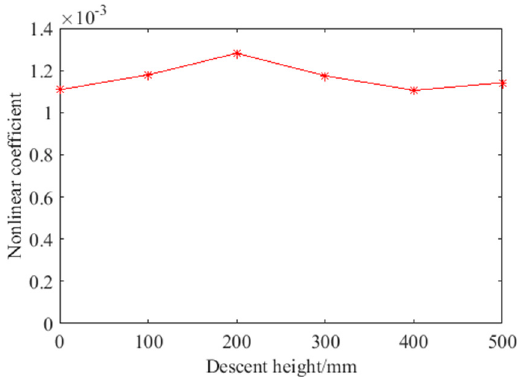
Figure 16. The received impact signal at different descent heights.